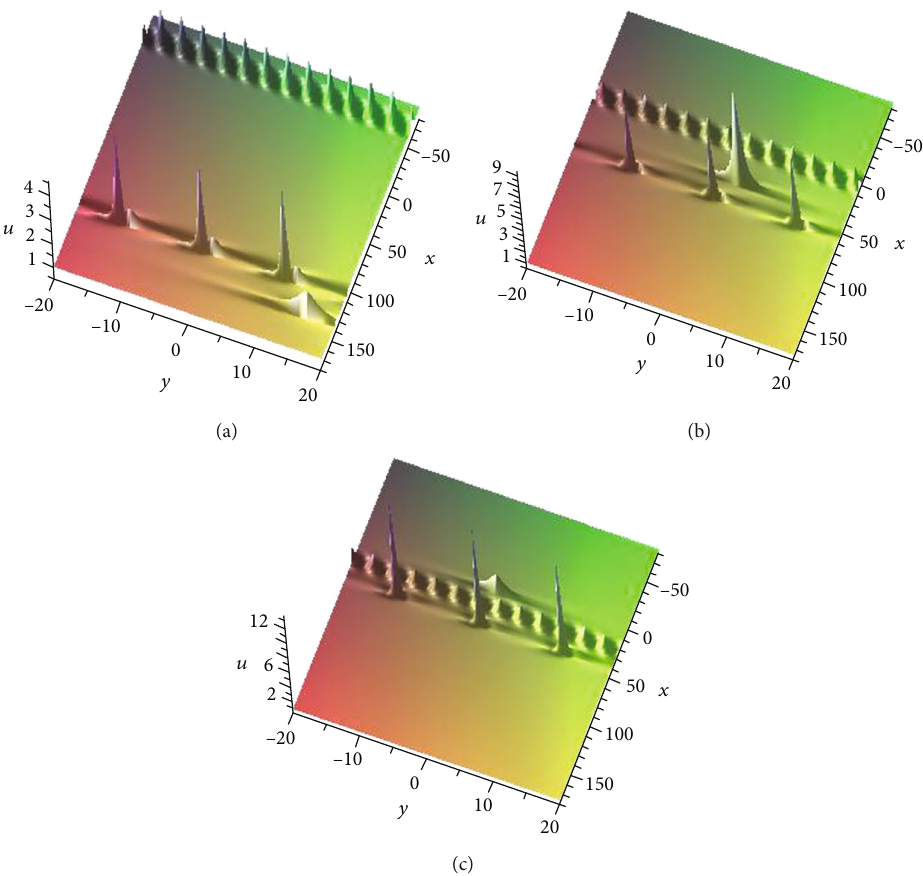
Figure 8: Propagation of hybrid solution composed of two breathers and a lump at di ff erent times: (a) n = − 180 , (b) n = − 50 , and (c) n = − 10